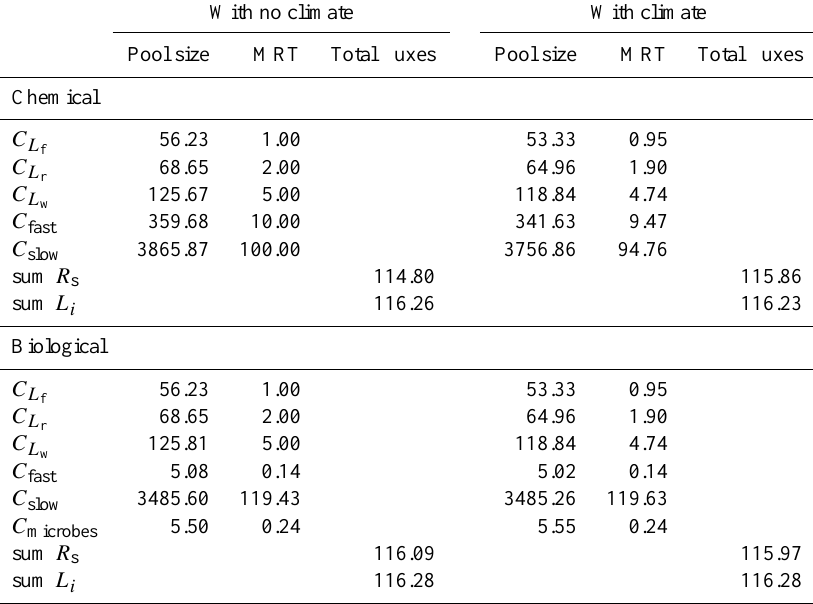
Table 2. Summary of the size of all carbon pools of the chemical and biological models including foliage litter ( C L ( C L , gCm − 2 ), wood litter ( C L , gCm − 2 ), fast soil carbon ( C fast , gCm − 2 ), slow soil carbon ( C slow , gCm − 2 ) and microbial biomass r w ( C microbes , gCm − 2 ) at the end of the 1000-year spin-up run, their respective mean residence time (MRT, years) and the sum over a